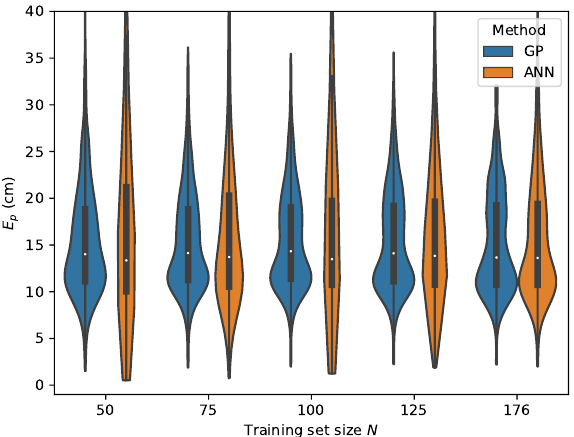
Figure 22. Cross-validation with set E where the r rel , all input features are used.